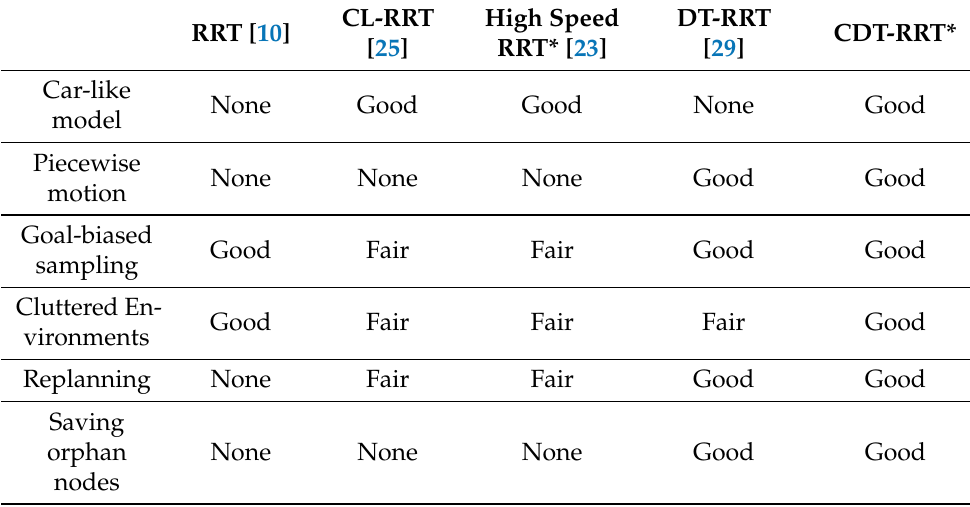
Table 1. The comparison of kinodyamic trajectory planners.